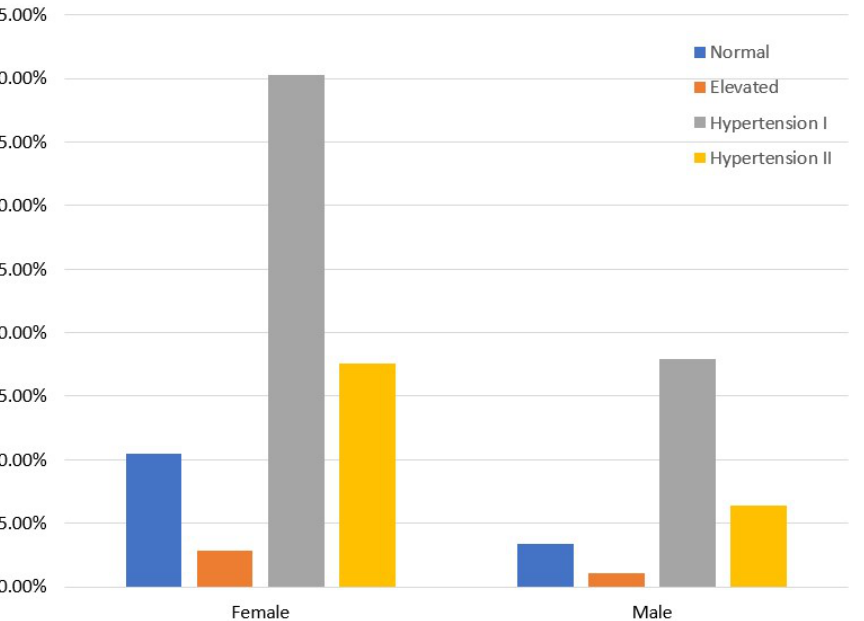
Figure 1. CVD participants’ distribution in terms of gender and blood pressure category in the balanced